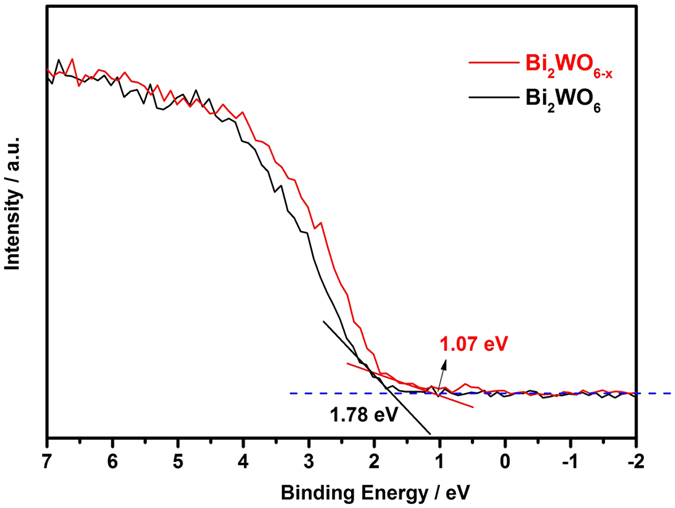
Valence-band XPS spectra of the pristine Bi2WO6 and Bi2WO6−x (150 °C for 5 h).